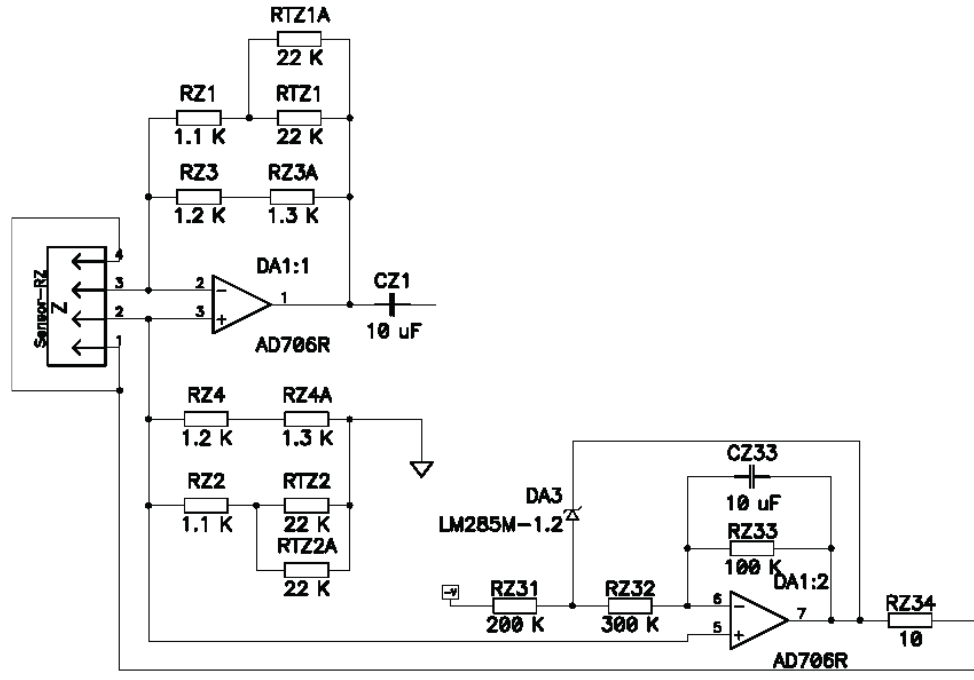
Figure 4. Diagram for electronic conversion unit of signal current into electric voltage.